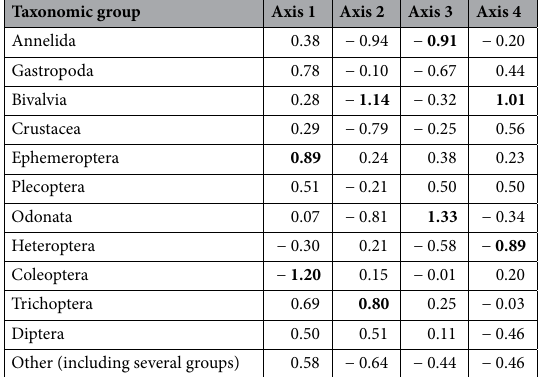
Table 1. The average position of taxonomic groups along the first four PCA axes. Minimum and maximum values are highlighted in bold.